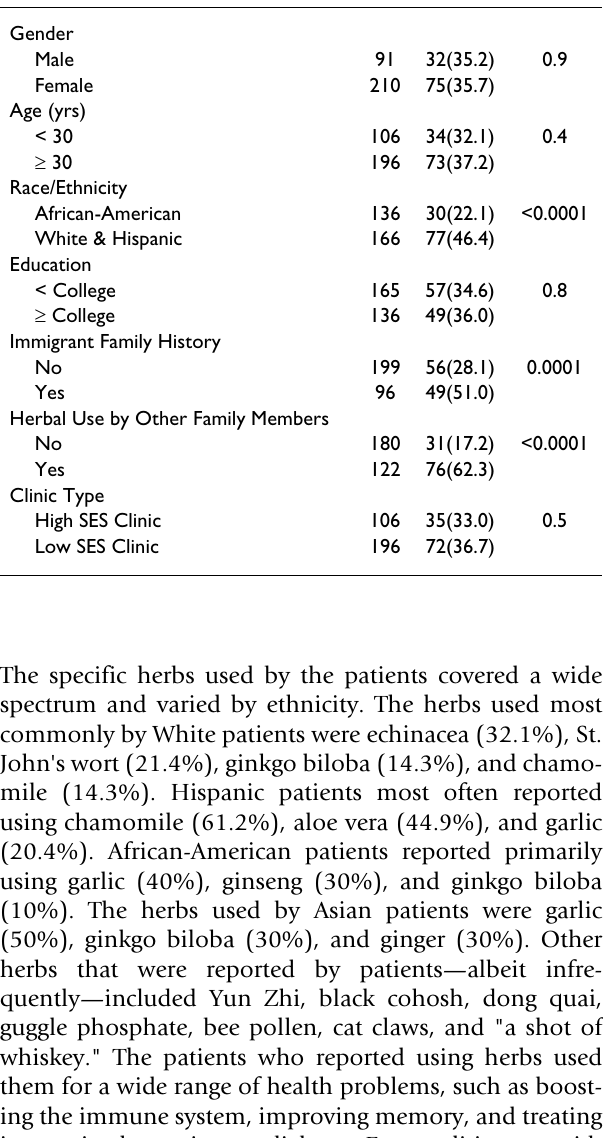
Use Among Urban Multiethnic Primary Care Patients (n = 302)